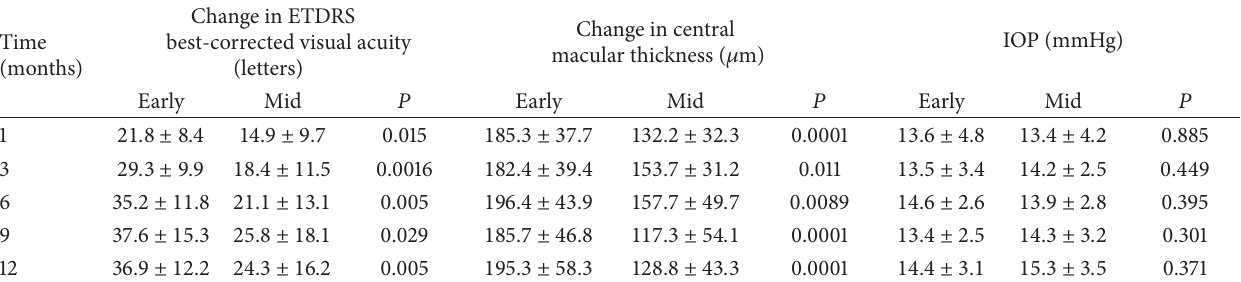
Table 2: Changes in best-corrected visual acuity (ETDRS), central macular thickness, and intraocular pressure during the 12-month monitoring